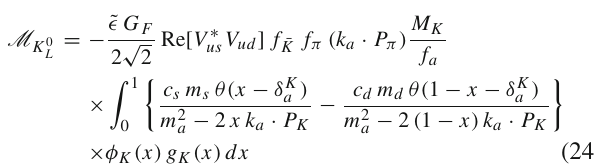
Fig. 2 Tree level contribution to the amplitude for the K 0 → π 0 a decay, with the ALP emitted from the K 0 meson. Diagrams where the ALP is emitted from the π 0 quarks are straightforward. Similar diagrams can be depicted for the CP conjugate process ¯ K 0 → π 0 a Theoperator insertion Γ ( 1 ) ⊗ Γ ( 2 ) is definedas γ μ P L ⊗ Γ